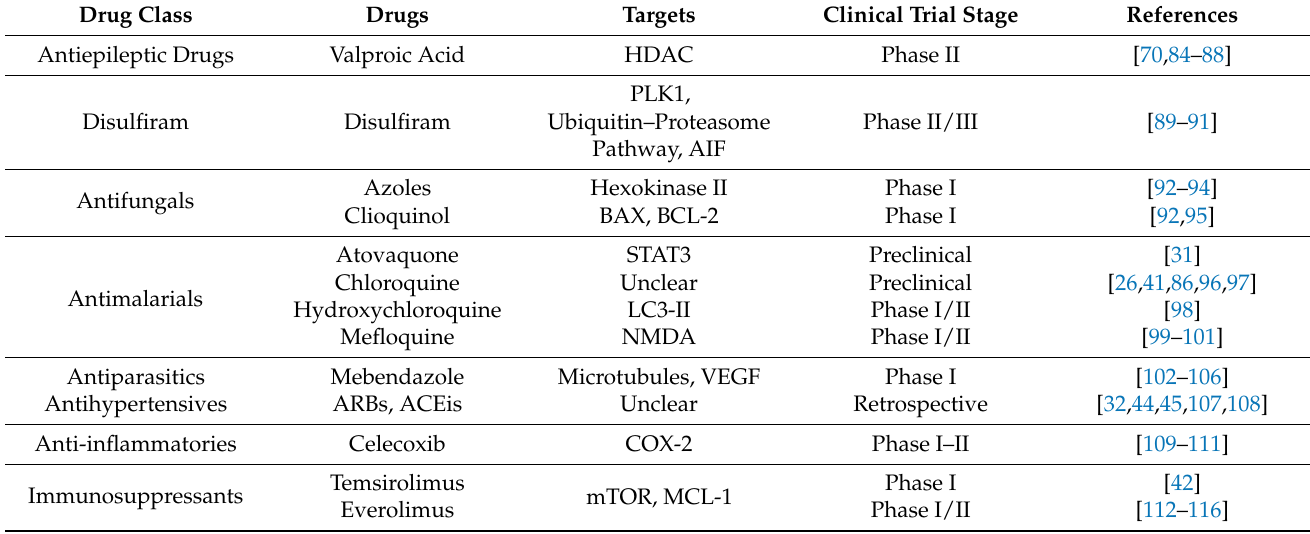
Figure 2. Cellular pathways and interactions detailing the key proposed mechanisms of drugs that have completed preclini- cal investigation and have also been studied in clinically. Abbreviations: Histone deacetylase (HDAC); O 6 -methylguanine- DNA methyltransferase (MGMT); histone methyltransferase (HMT); carbonic anhydrase 2 (CA2); muli-drug resistance protein (MDR); N-methyl-D-aspartate receptor (NMDAR); Indoleamine 2,3-dioxygenase (IDO); glioma-associated oncogene (GLI1); protein patched homolog 1 (PTCH1); programmed death-ligand 1 (PD-L1); polo-like kinase 1 (PLK); mitogen- activated protein kinase kinase (MEK); mechanistic target of rapamycin (mTOR); hexokinase II (HKII); glycogen synthase kinase (GSK3B); phosphoinositide 3-kinase (PI3K); signal transducer and activator of transcription 3 (STAT3); phosphatase and tensin homolog (PTEN); protein kinase B (AKT); reactive oxygen species (ROS); rat sarcoma (RAS); extracellular signal-regulated kinase (ERK); vascular endothelial growth factor receptor (VEGFR); endothelial growth factor receptor (EGFR); Bcl-2-associated X protein (BAX); B-cell lymphoma 2 (BCL2); B-cell lymphoma-xL (BCL-XL): B-cell lymphoma 3-encoded protein (BCL-3). Table 2. Drug class, specific drug, drug target, and current clinical phase of repurposed agents currently undergoing clinical Table 1. Drug class, specific drug, and drug targets of repurposed agents currently undergoing preclinical investigation.